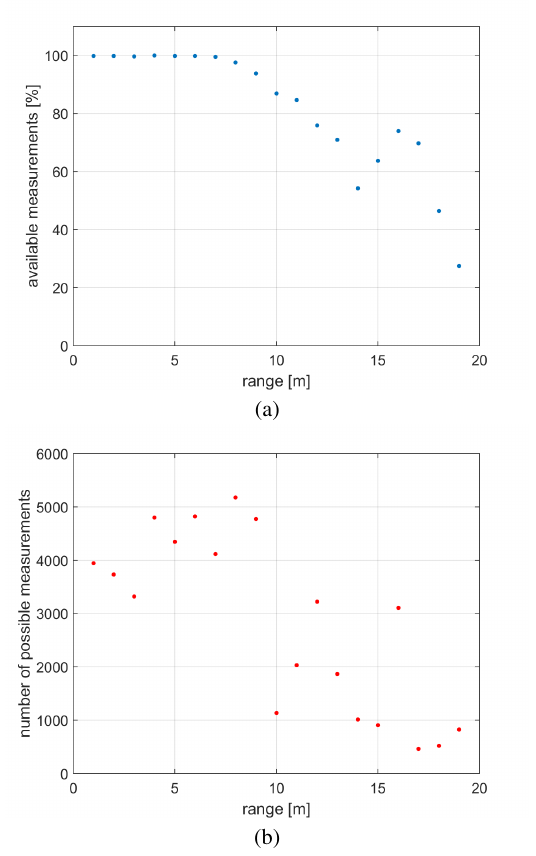
Figure 4. (a) Acquisition rate as a function of the range value. (b) Number of possible measurements considered to compute acqui- sition rates in (a).